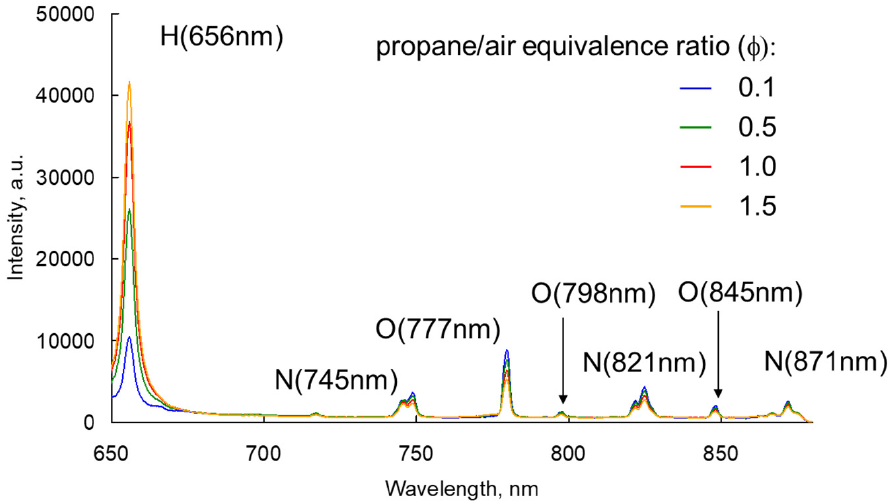
Figure 4. LIBS spectrum of the propane–air mixture. The H intensity ratio vary with the change in equivalence ratio.